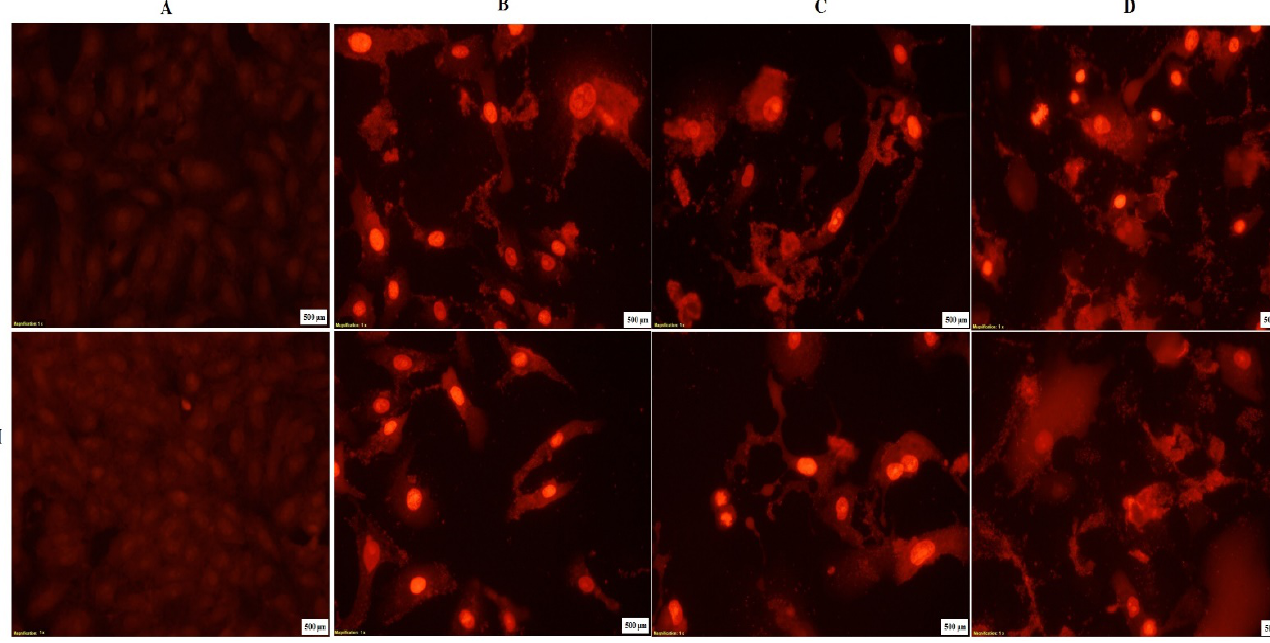
Figure 6. Fluorescence photograph of HepG-2 cells stained with PI dye under a fluorescence microscope after treatment with the modified WO 3 -Cys and WO 3 -Trp NPs (I and II, respectively). HepG-2 cells were exposed to different concentrations of 0.0, 0.1, 0.2, and 0.3 mg/mL ( A – D ). The scale bar in all images is 500 µm.